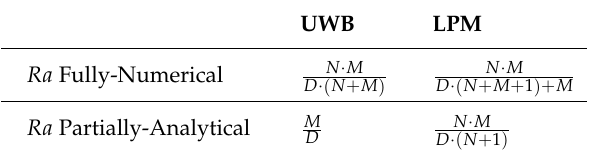
Table 4. Ratio between the number of equations and the number of unknown